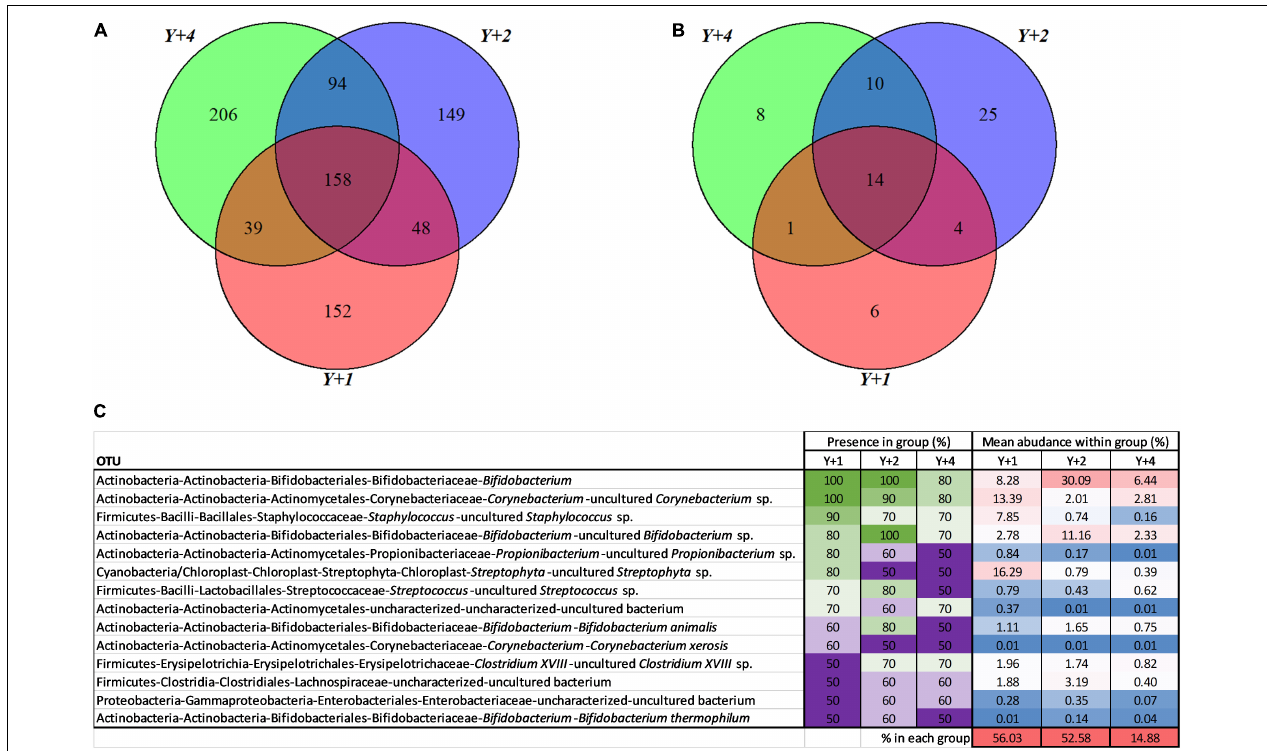
FIGURE 2 | Core microbiota. (A) Venn diagram depicting unique and shared OTUs among different age groups. (B) Venn diagram depicting unique and shared OTUs among different age groups including only OTUs that are present at least in 50% of the samples of each group. (C) Abundance table representing the core 14 OTUs from (B) . The presence within each group, in percentage, is highlighted with a color scale with green being the highest and purple the lowest. The mean abundance of each OTU within each group, in percentage, is highlighted with a color scale being red the highest and blue the lowest. The last row represents the percentage of the total microbiota per group constituted by the core microbiota. Y + 1, Y + 2, and Y + 4 correspond to 1-, 2- and 4-year-old gilthead sea bream,